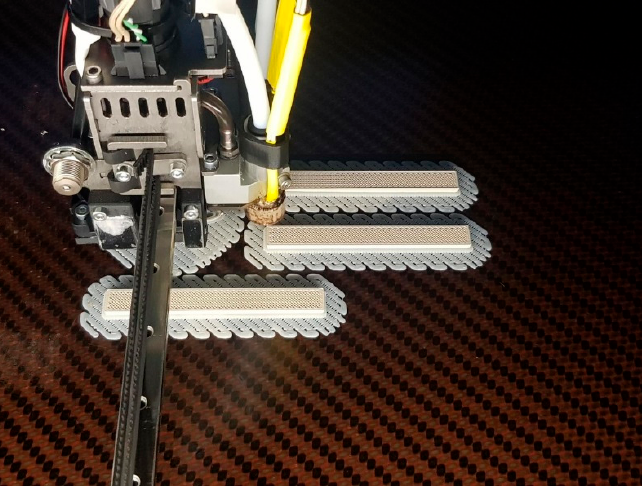
Figure 14. Printing of the flexural samples.